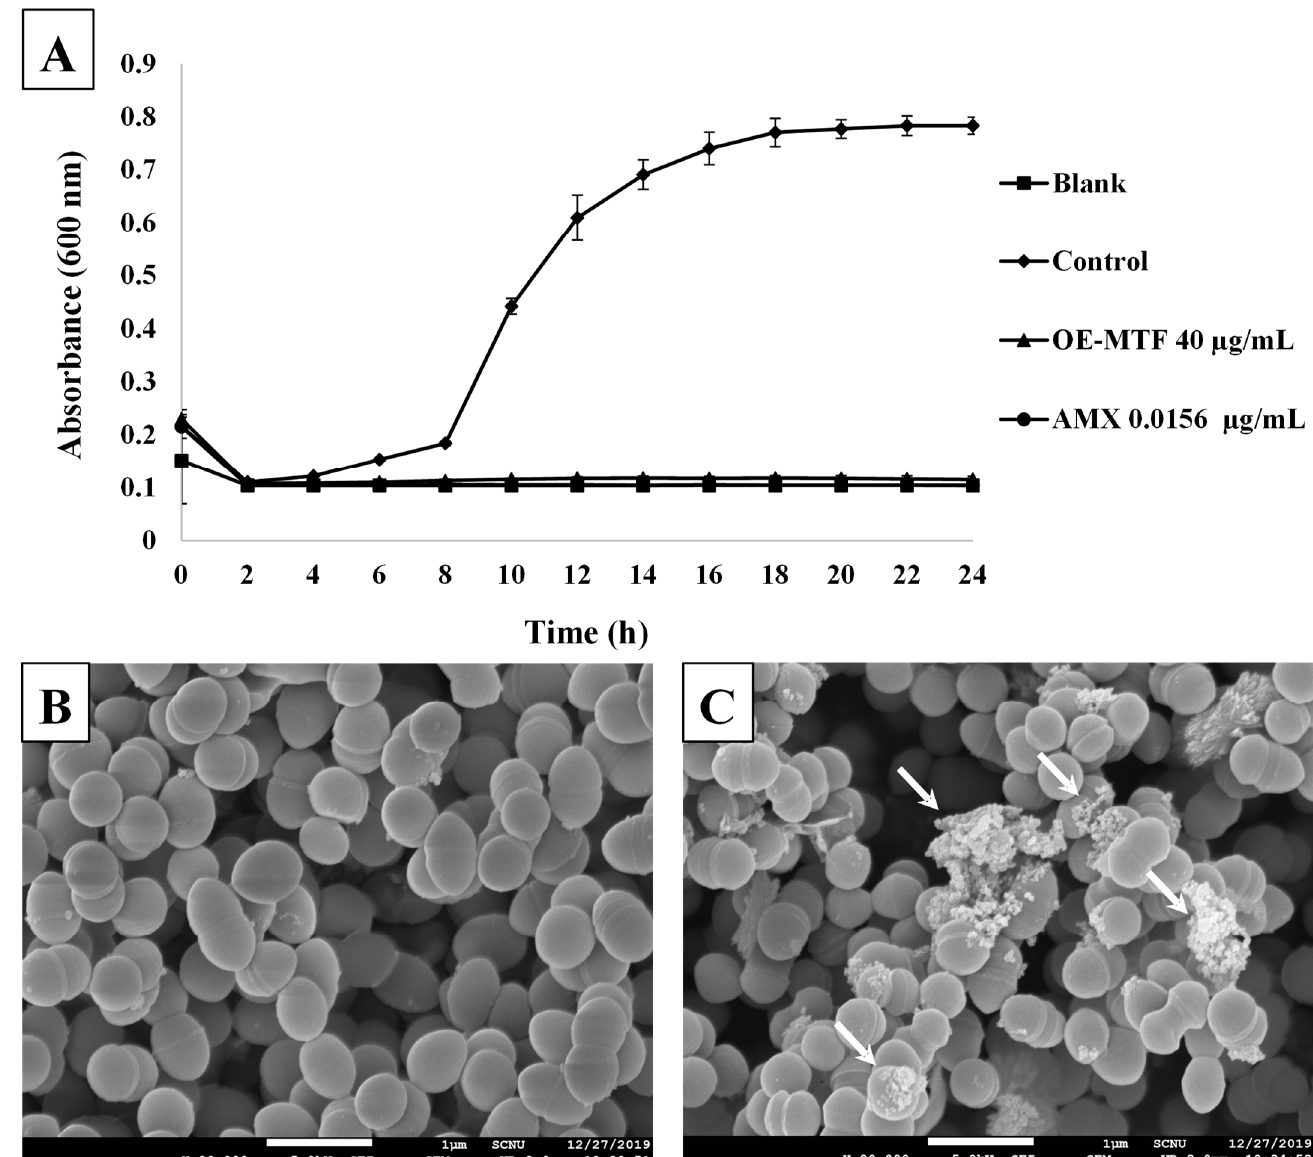
Figure 4. Time-growth curve of S. iniae at an MIC of 40 μ g/mL ( A ) and scanning electron microscope (SEM) observation of S. iniae ( B , C ). Morphology of untreated bacteria ( B , ×20,000) and bacteria treated with OE-MTF at 40 μ g/mL for 20 h ( C , ×20,000). White arrows indicate destruction of bacterial cells with lysed and indistinguishable cytoplasmic membrane structures.